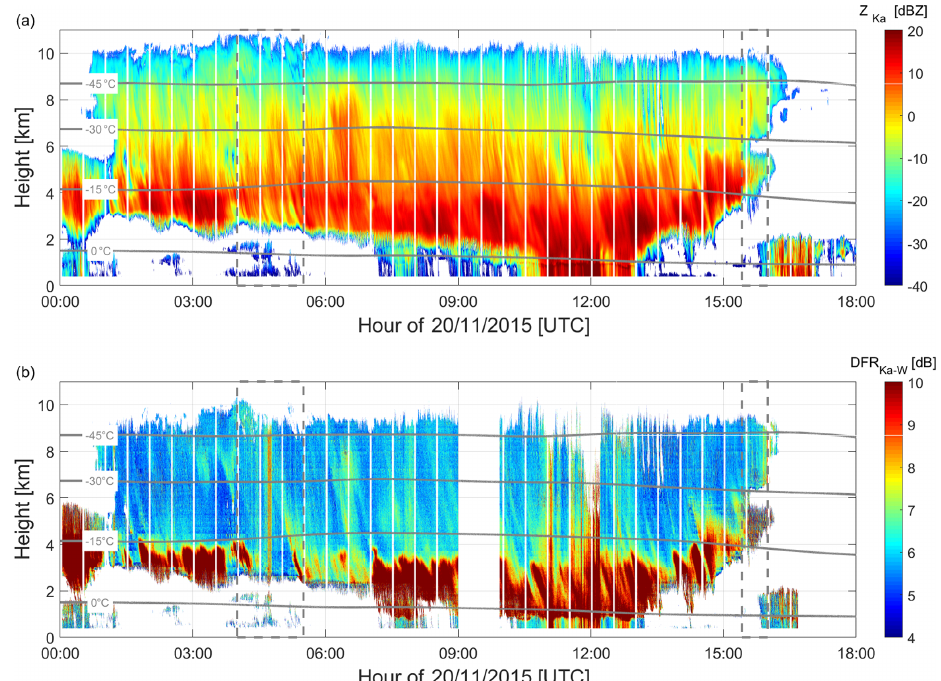
Figure 4. Time–height (UTC–km) plots of the (a) K a reflectivity and (b) K a –W DFR observed at the Jülich Observatory on 20 May 2014. The gray lines show the − 45, − 30, − 15, and 0°C